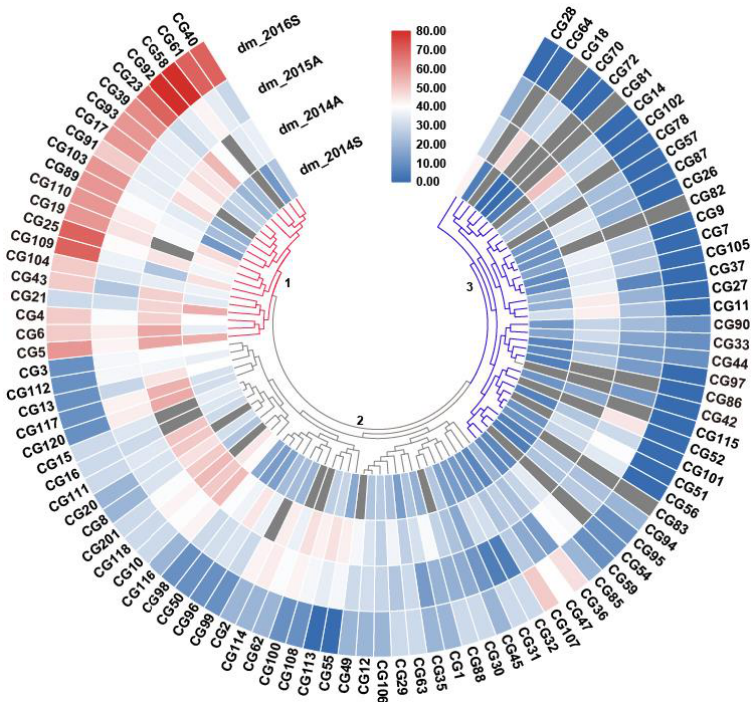
Figure 1. The heatmap depicting the phenotypic distribution of disease index (DI) of downy mildew (DM) resistance in four environments. The three clusters of the core germplasm (CG) lines are numbered with 1 to 3, and data of mean DI per CG line in the four experiments were used for this clustering analysis. The numbers next to the color key represent DI values. Blue means resistant and red susceptible. The intensity of the color indicates the level of resistance/susceptibility.